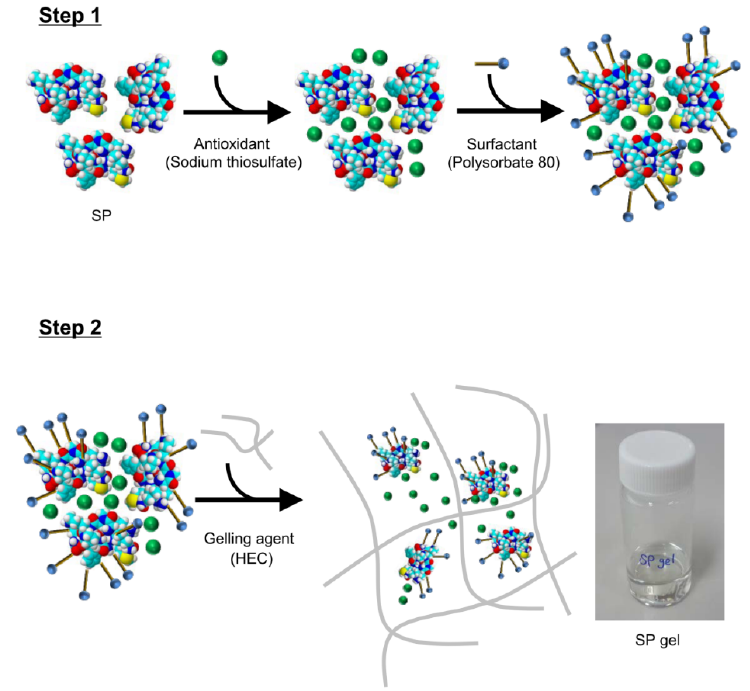
Figure 7. Schematic representation of SP gel formation for improved stability. SP, sodium thiosulfate, and polysorbate 80 are mixed together (Step 1) and then, HEC is added to the mixture, resulting in the formation of hydrogel networks (Step 2). SP is represented by space-filling models; green balls and blue sticks represent sodium thiosulfate and polysorbate 80, respectively, and gray lines represent HEC.